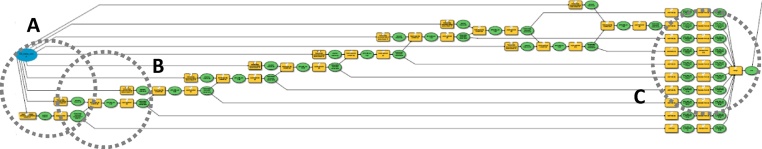
The workflow sequences of the Stage 3 as modeled in ModelBuilder for assigning TCD value of 10.